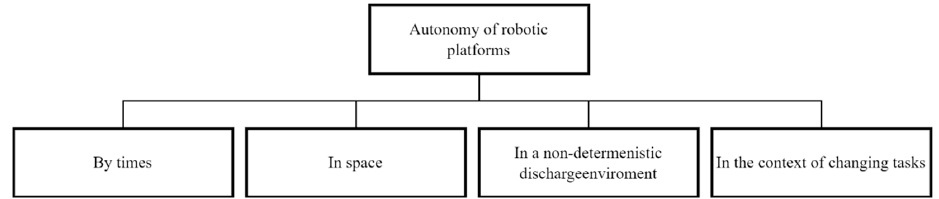
Figure 1. Classification of Autonomous robots.